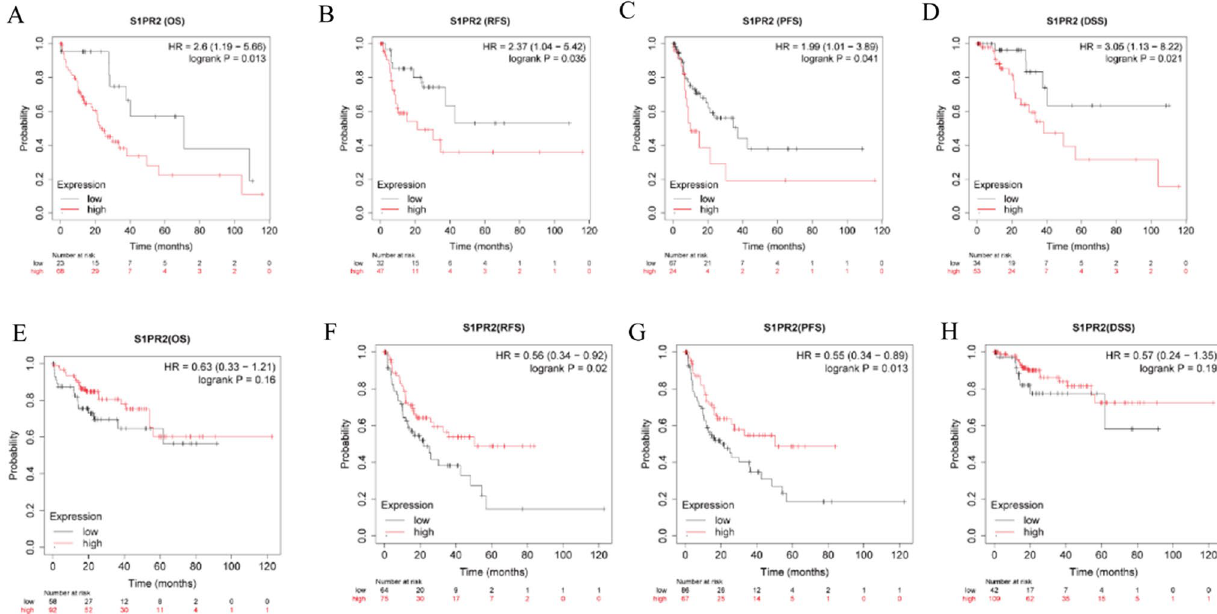
Fig. 1 S1PR2 was linked to poor prognosis of NAFLD-HCC patients. A–D correlation between S1PR2 and the prognosis of NAFLD-HCC patients in terms of OS, RFS, PFS, and DSS. E–H correlation between S1PR2 and the prognosis of hepatitis virus-related HCC patients in terms of OS, RFS, PFS, and